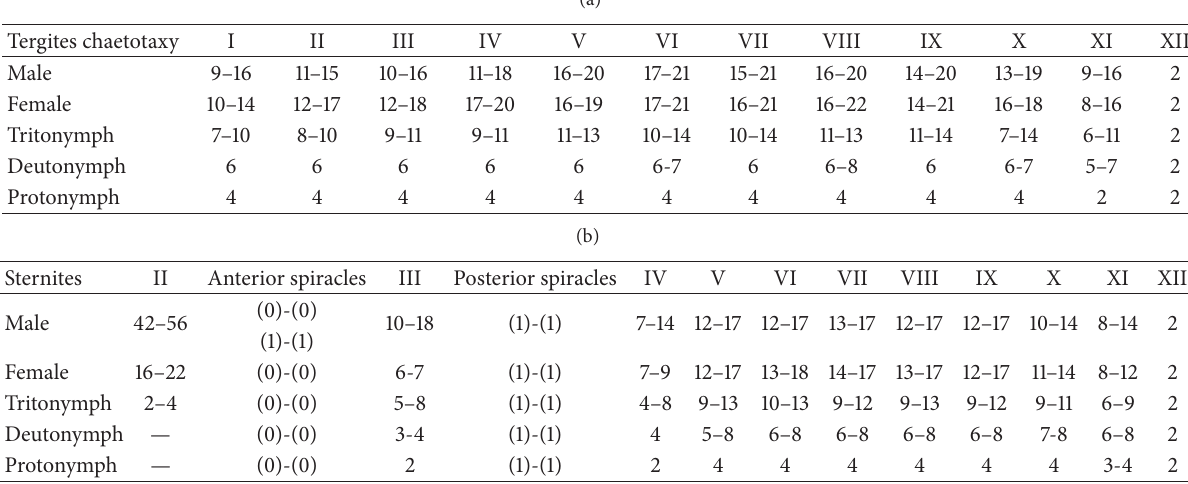
Table 3: Tergal and sternal chaetotaxy of postlarval stages of Dactylochelifer gracilis .